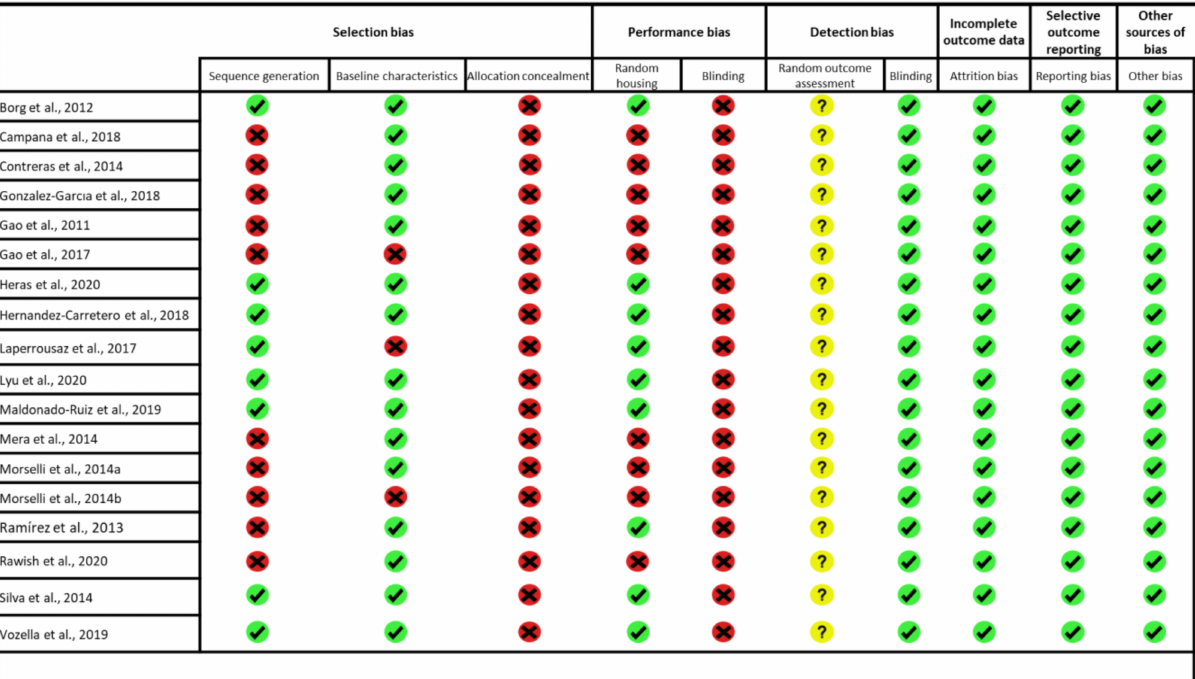
Figure 3. Risk of bias (RoB) from in vivo studies. Summary of the authors’ judgments concerning risks from included in vivo